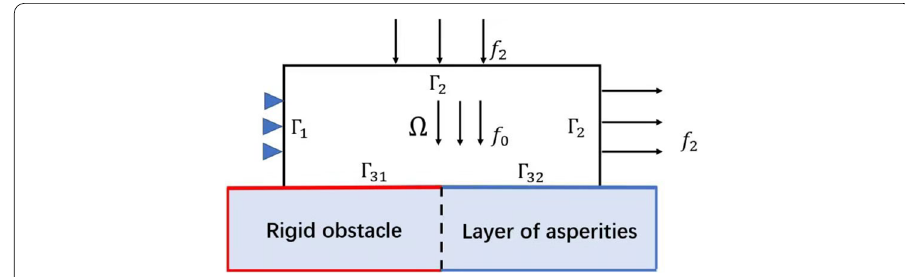
Figure 1 The viscoelastic contact model